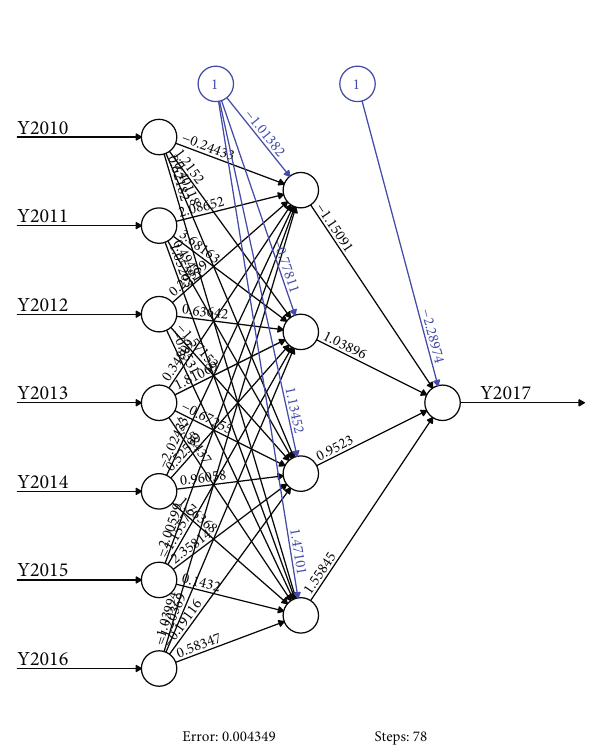
Figure 4: Visualisation of the architecture of the FFNN